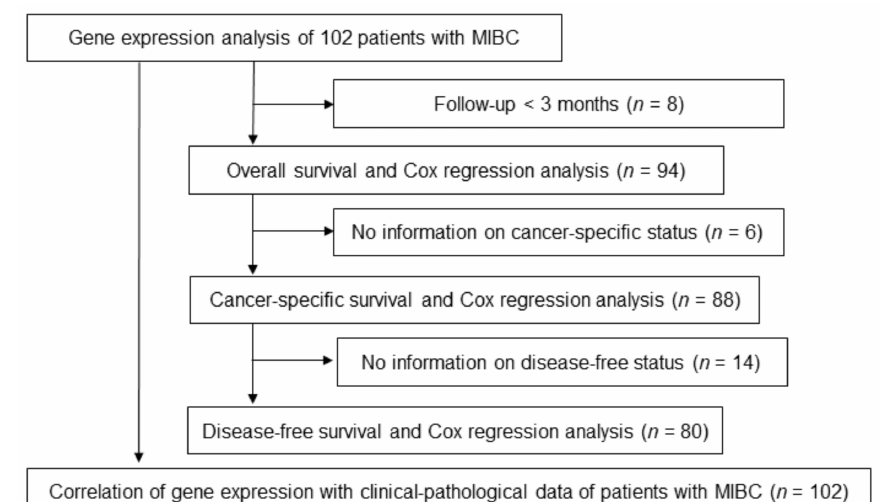
Figure 1. Inclusion and exclusion scheme of the Mannheim cohort. Abbreviations: MIBC, muscle- invasive bladder